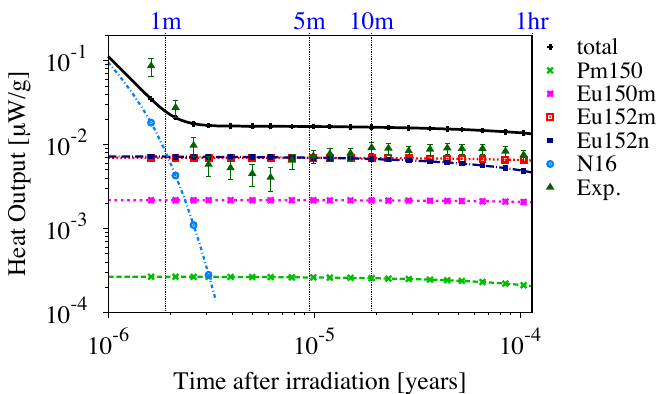
Figure 4: FISPACT-II&TENDL-2017 simulation results for the decay-heat experiment for europium oxide in the FNS benchmark,